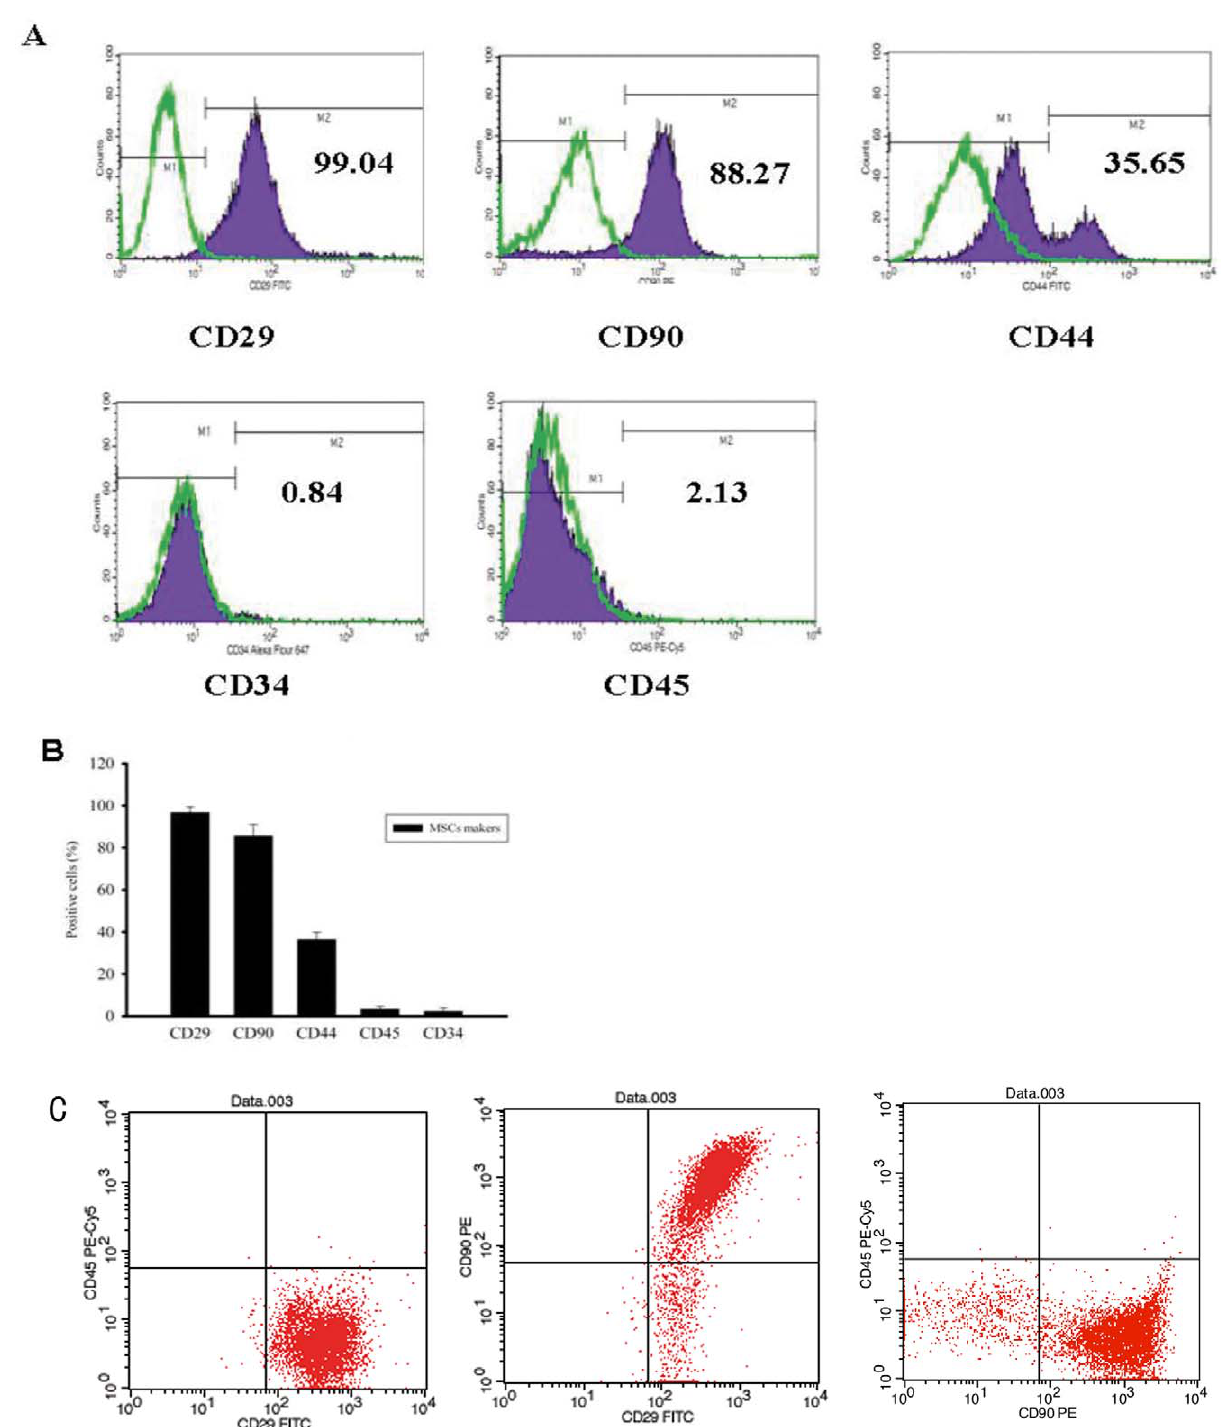
Figure 1. Cell surface markers of MSCs. The surface marker molecules expressed by the Passage 5 culture of MSCs were analyzed by flow cytometry. (B) Quantification by image analysis of the positive cells. The numbers in the histograms indicate the mean fluorescence of each MSC markers. (C) Percent of MSCs obtained from culturing bone marrow cells. doi:10.1371/journal.pone.0055487.g001 of the JAK1 / STAT3 signaling pathway in the effects of MSCs on DCs. China) was added to the co-culture for 48 h to investigate the role